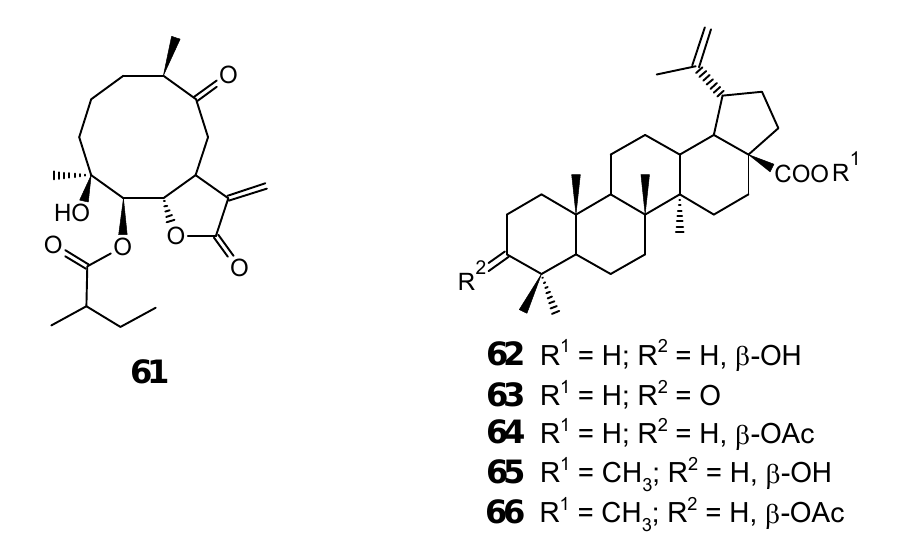
Figure 8. Antiplasmodial terpenes 61-66